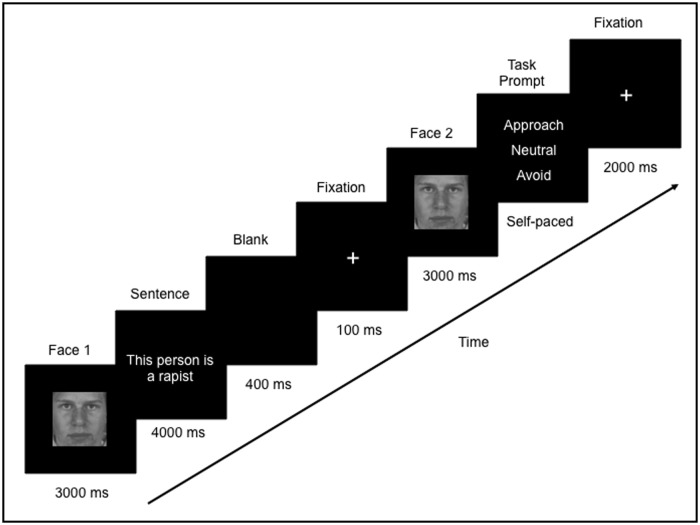
Example of one trial in the study. Participants freely viewed a face (Face 1) followed by a sentence that was either negative or neutral. The same face was presented again (Face 2) and participants were asked to judge whether they would want to approach, avoid or neither approach or avoid (remain “neutral” to) that person.